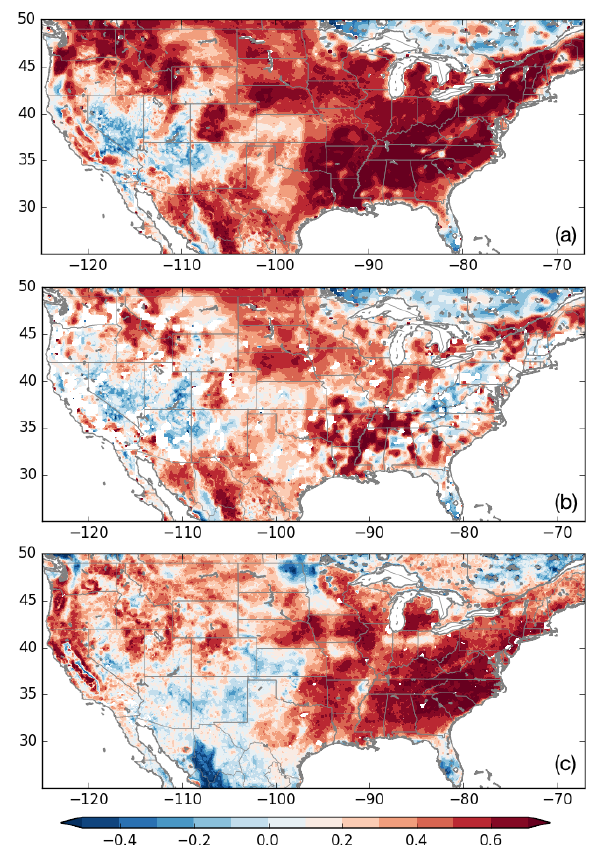
Figure 2. Correlation of VOD retrievals from LPRM X-band (a) , LPRM C-band (b) , and SMAP L-band (c) against the MODIS- based LAI retrievals. The LPRM and SMAP comparisons employ data during the 2002–2018 and 2015–2018 time periods, respec-